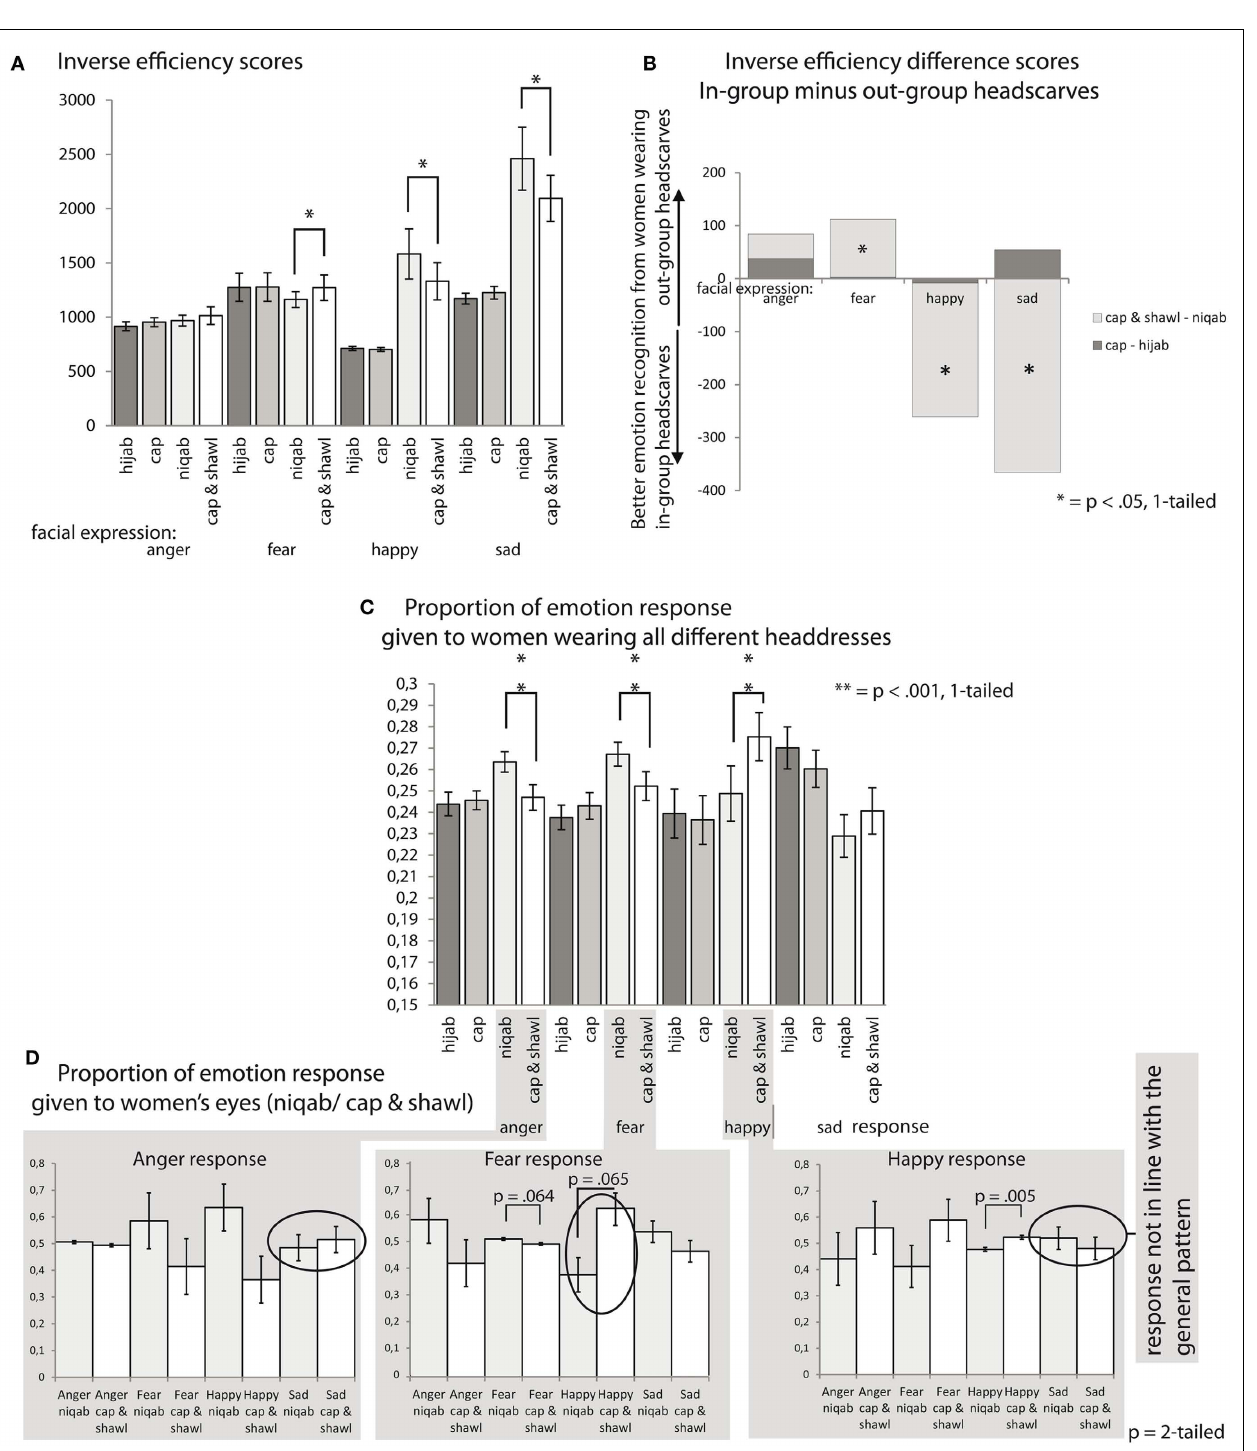
better recognized, (C) the proportion of an emotion label given to a facial expression in different headdress-contexts (i.e., the number of fear responses to a niq ¯ ab divided by the total number of fear responses), (D) the proportion of an emotion label given to emotional eyes in the context of a niq ¯ ab or cap and shawl (i.e., the number of fear responses to a fearful face covered with a niq ¯ ab divided by the number of fear responses to a fearful face covered with a niq ¯ ab plus a cap and a